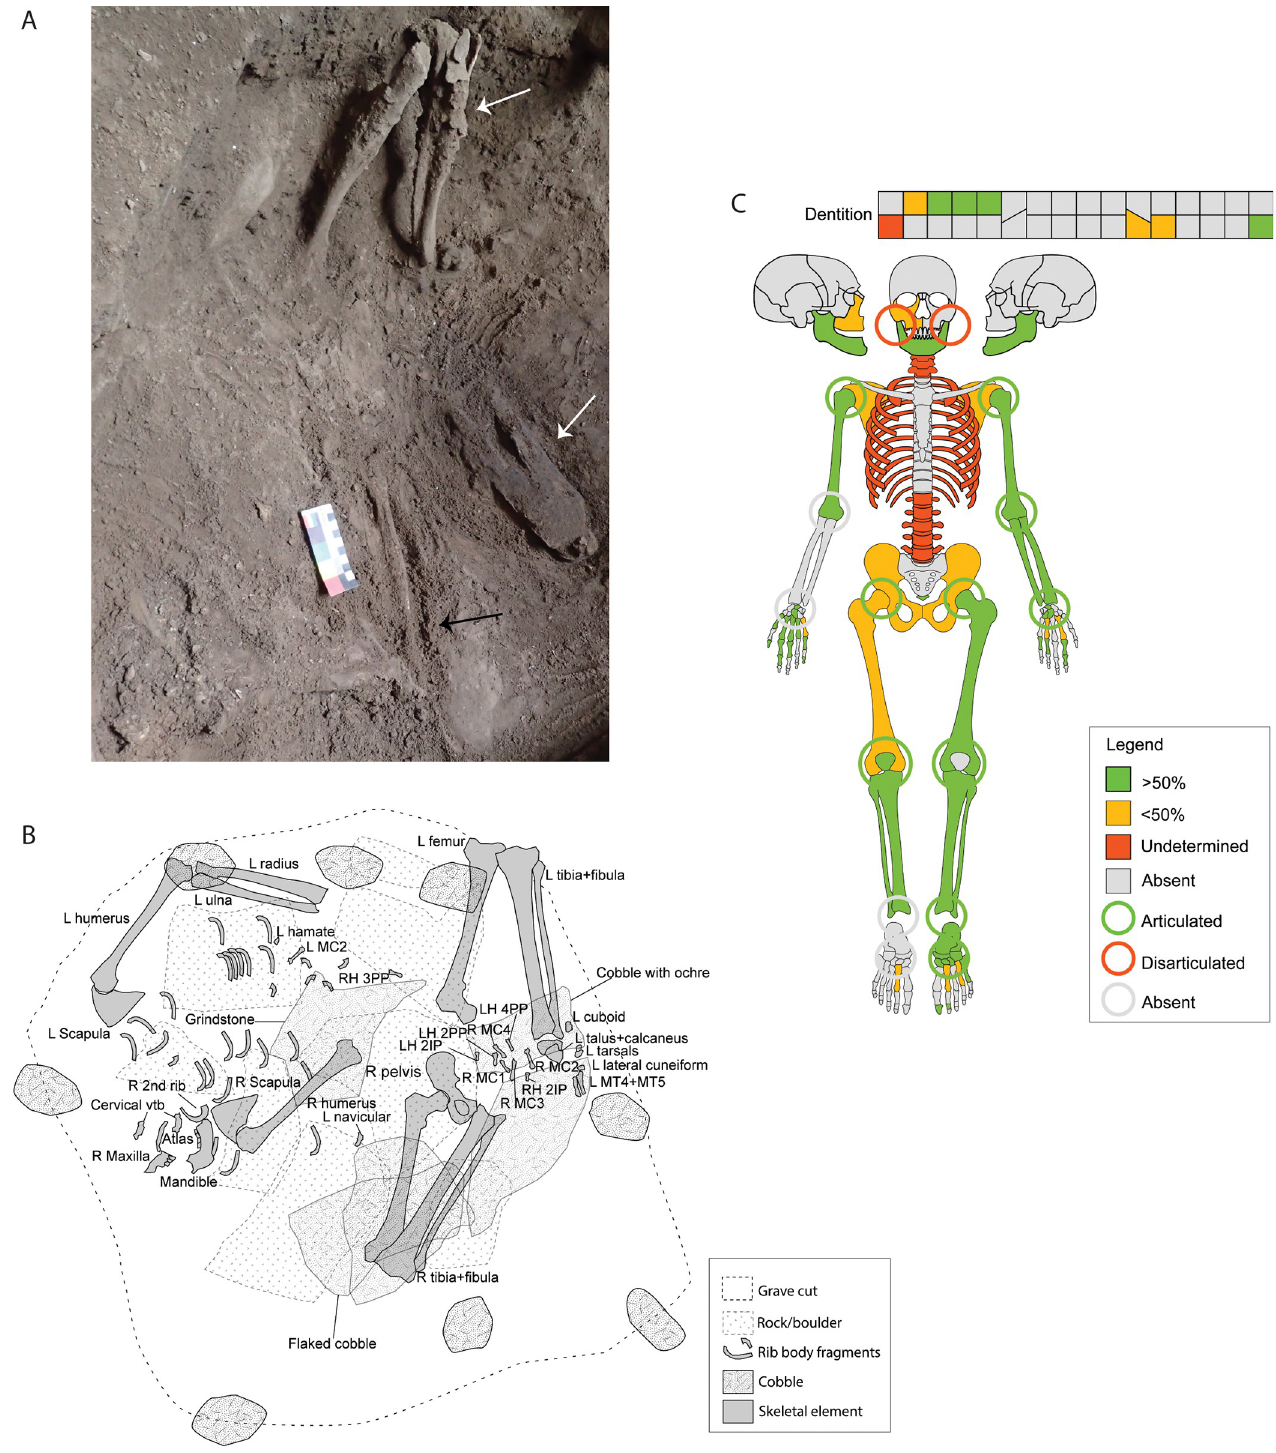
Fig 7. Skeletal elements from DE B2. A) General view of burial showing vertical legs (white arrows) and articulated upper right limb (black arrow); B) Sketch drawing of the position of the skeletal elements based on the spatial plotting of elements during fieldwork. Only those elements plotted are illustrated. Dashed lines in rock/boulders indicate that these elements were on top of the skeletal remains, removed before excavation of the burial; R = Right; L = Left; RH = Right hand; LH Left hand; MC = Metacarpal; MT = Metatarsal; PP = Proximal phalanx; IP = Intermediate phalanx; C) Skeletal diagram indicating the elements documented in DE B2 and joint assessment